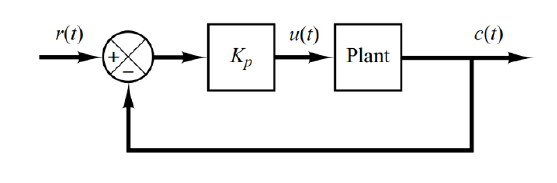
Figure 4. Giving 𝐾 𝑝 Value to Plant